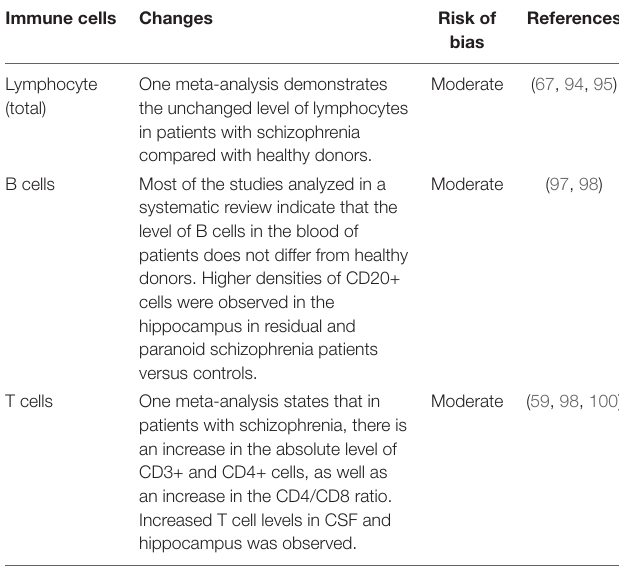
TABLE 4 | Quantitative changes in adaptive immunity cells in